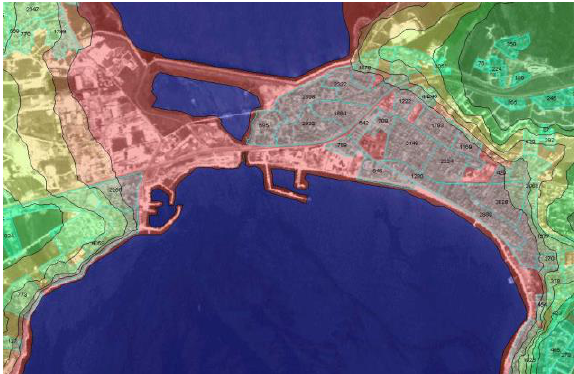
Figure 1: Tsunami Run-up simulation represented as a Map of an area near Istanbul calculated via GIS using land-use data and a DTM (Kemper et.al